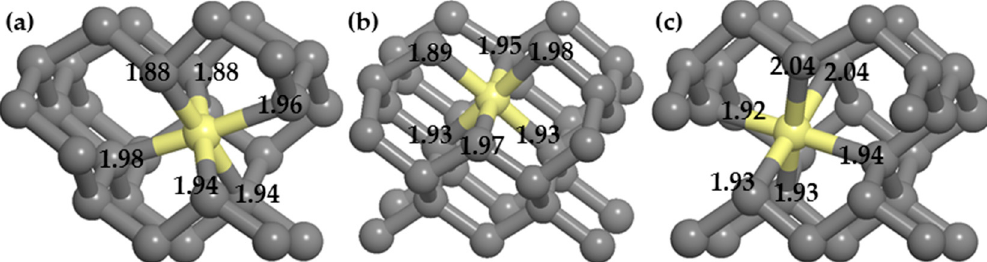
Figure 4. The optimized structures of PV complex when P (yellow) is in the site 5A on the (001) surface. ( a – c ) represent V in the site A, B and C, respectively, the number in the figure represents the length of P–C bonds.